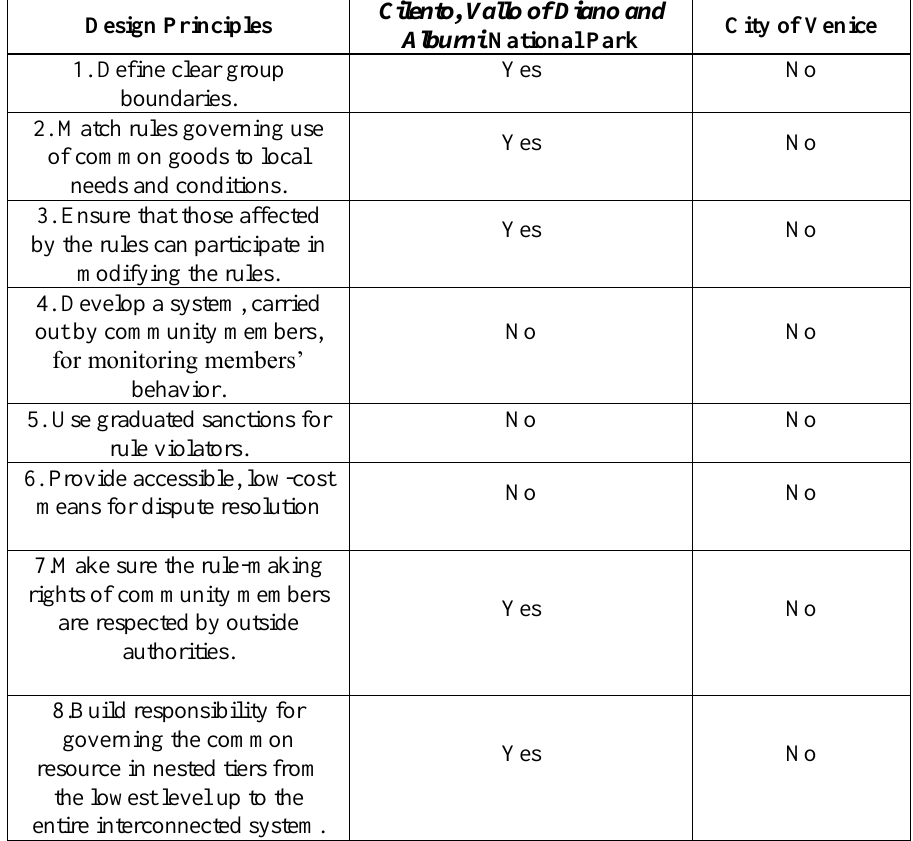
Table 2: Organisational Principles of Ostrom's Theory Applied to Cases Studies Design